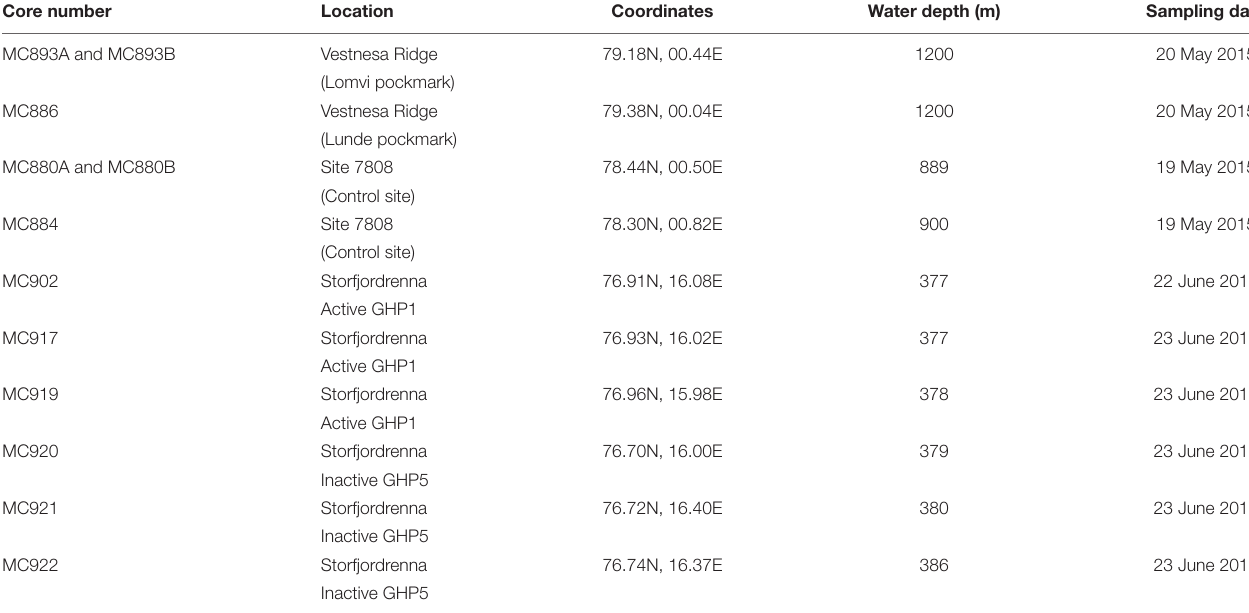
TABLE 1 | Core numbers, location, coordinates, water depths, and dates of sampling. Core number Location